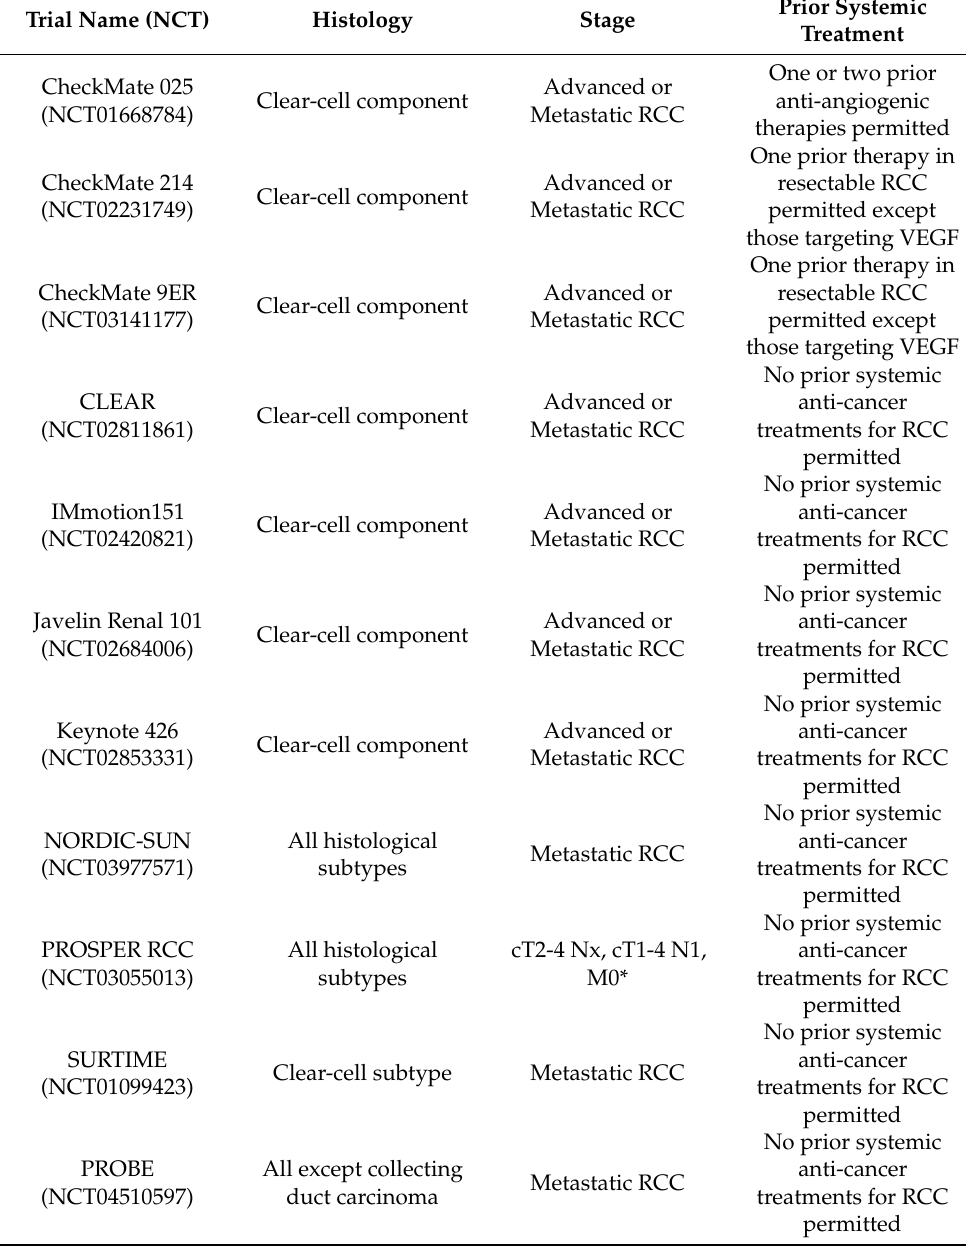
Table 3. Inclusion criteria of phase III clinical trials exploring advanced or metastatic RCC. *PROSPER RCC included M1 disease that is planned to be definitively treated within 12 weeks of nephrectomy such that the patient is M0, no evidence of